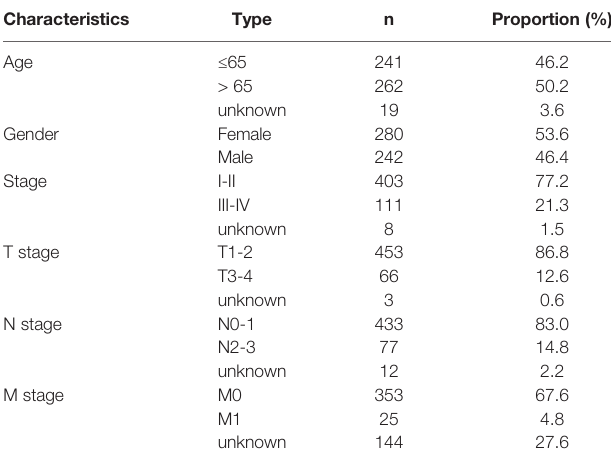
TABLE 1 | Clinicopathological characteristics of 522 LUAD patients from TCGA cohort.